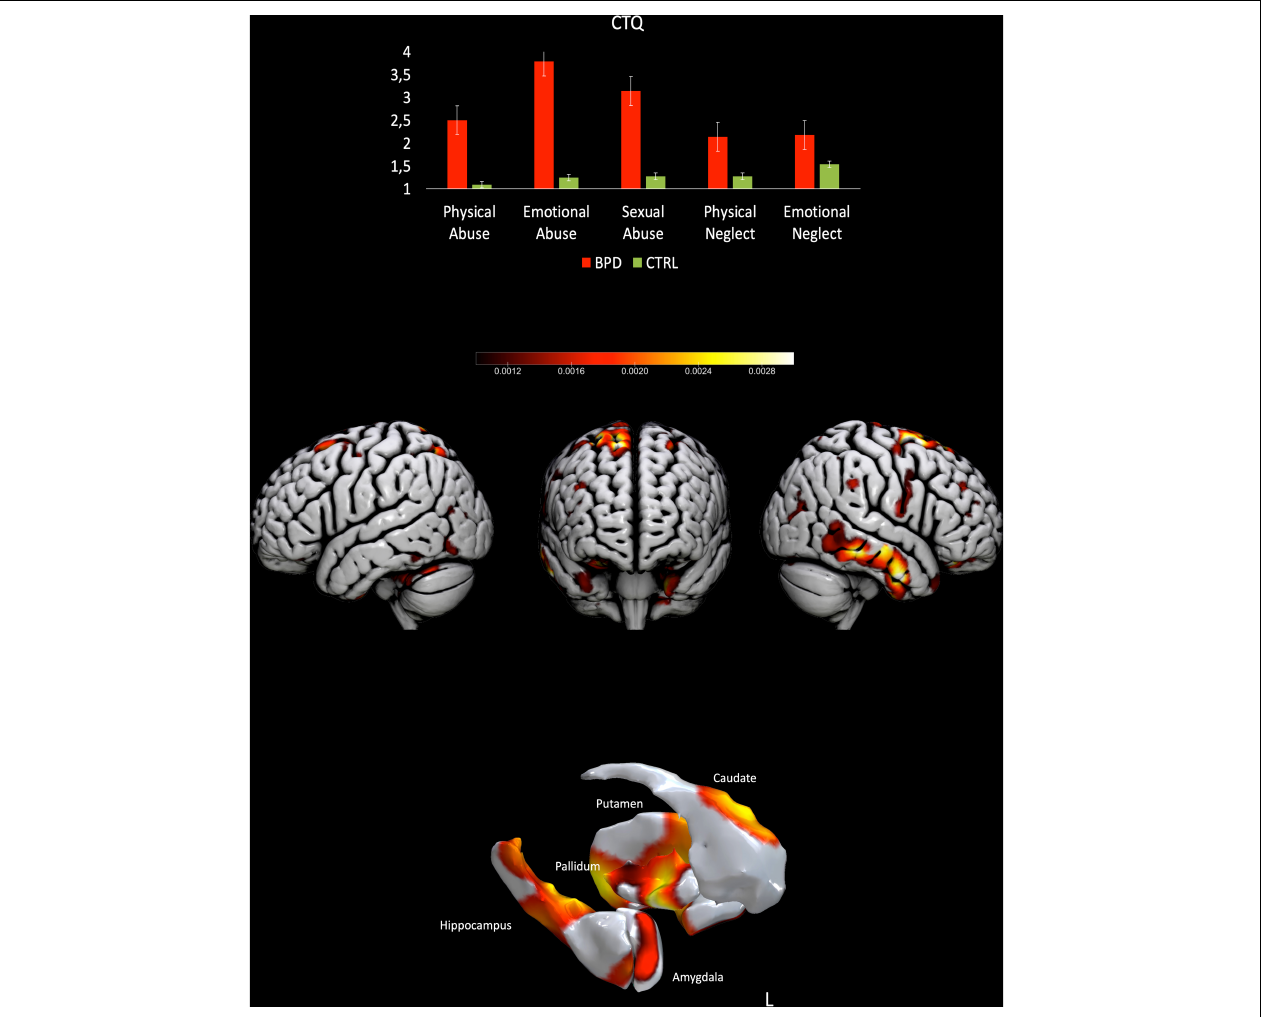
FIGURE 1 | Results from the prediction of sexual trauma for BPD patients. Upper part, results from the CTQ-subscales scores for both BPD patients and controls. Lower part, surface plots, including subcortical reconstruction of the significant regions predicting Sexual trauma in BPD